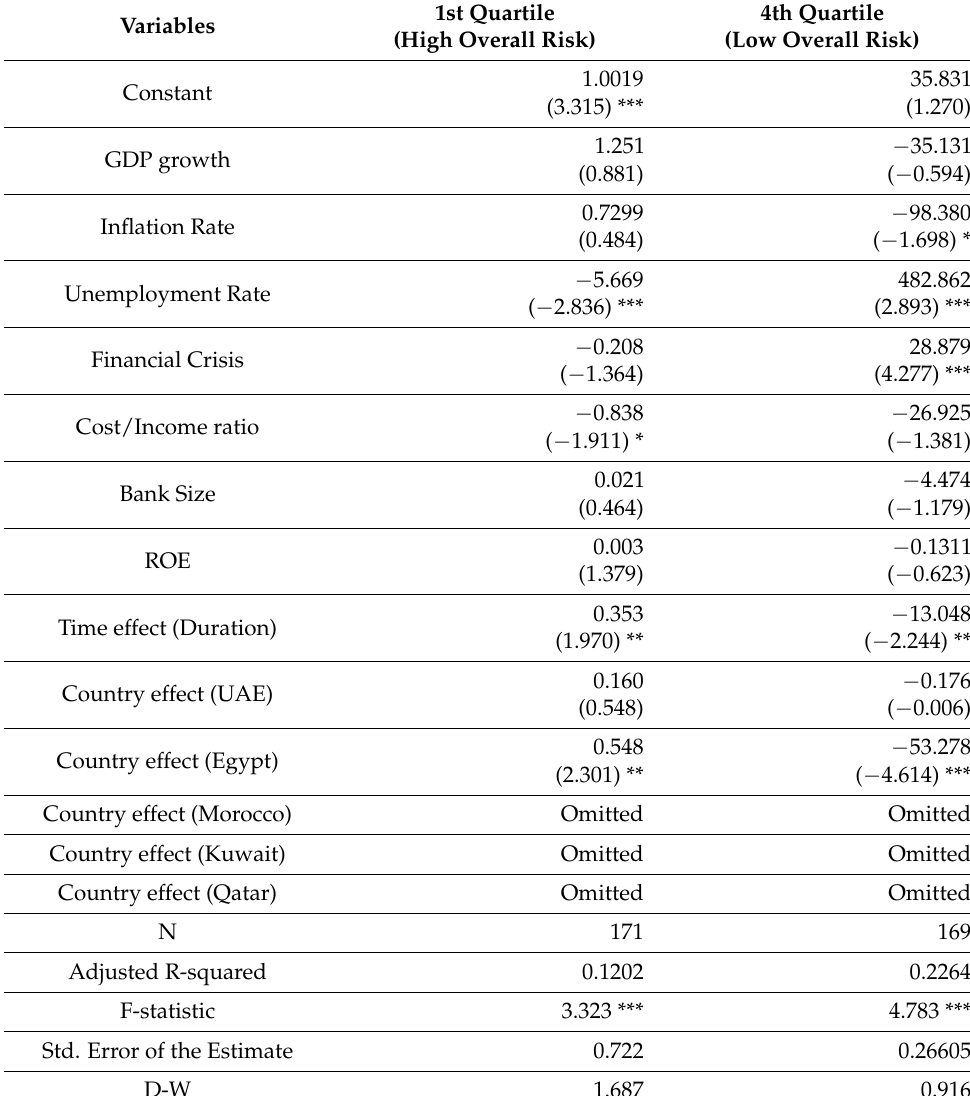
Table 5. The Robustness of the Scale of Total Bank